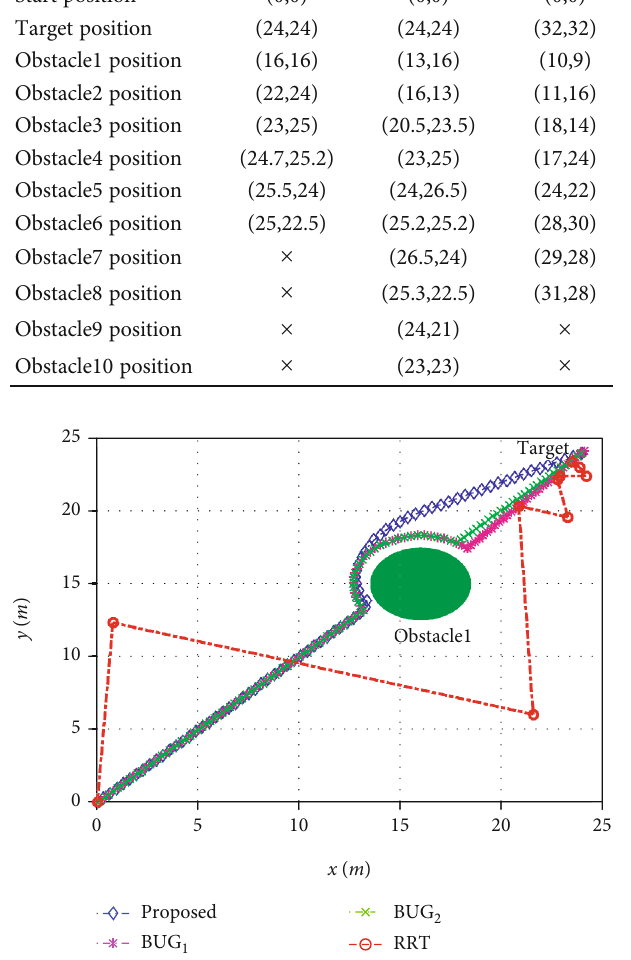
Figure 11: Scenario 1: the result of path planning of the four algorithms with an